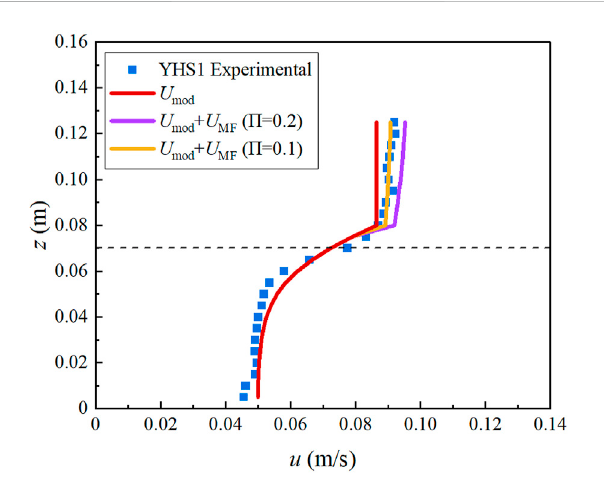
FIGURE 10 The effect of wake term to the velocity model of run YHS1. The black dotted line represents the height of the short